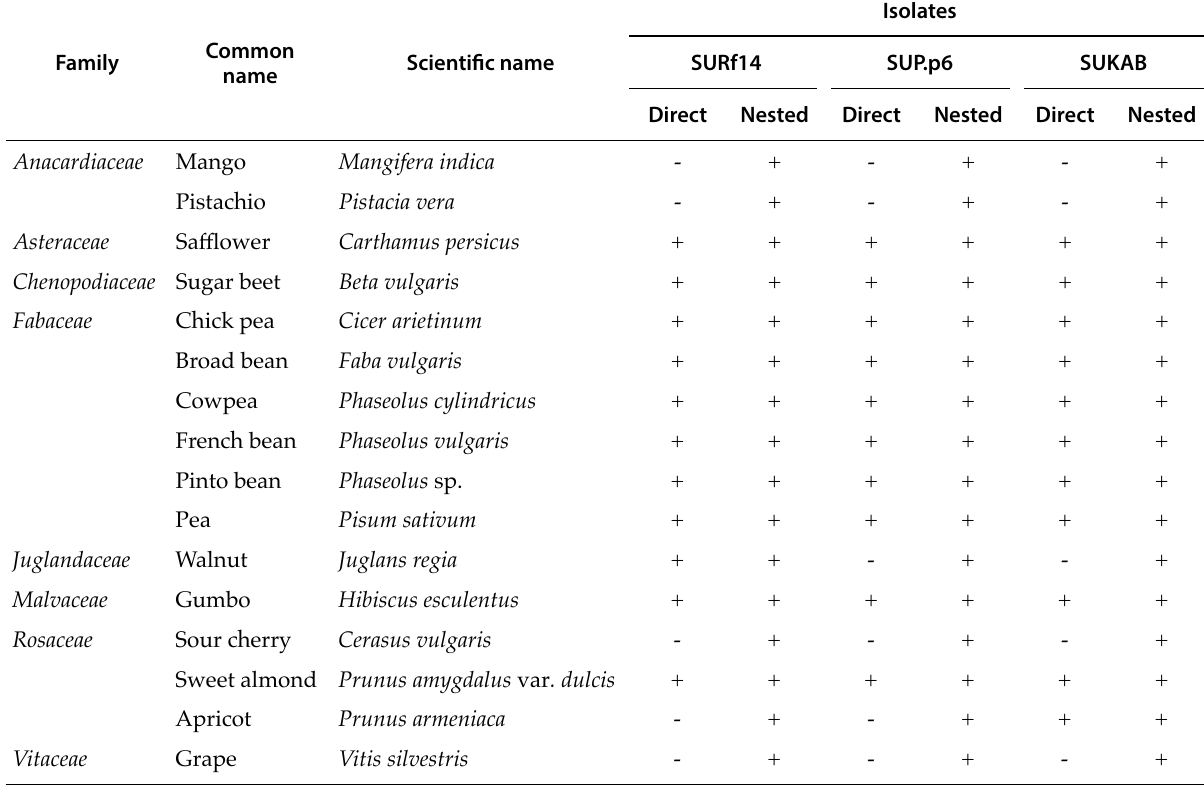
Table 4. Detection of Phytophthora pistaciae isolates in inoculated susceptible hosts by direct and nested PCR using species specific ITS-SF1 and ITS-SR1 primers and universal ITS6 (as forward), and ITS4 (as reverse) primers as external set. All pistacio cultivars including Badami, Ghazvini, Sarakhs showed the same results.